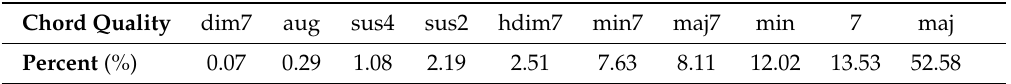
Table 3. Chord Quality